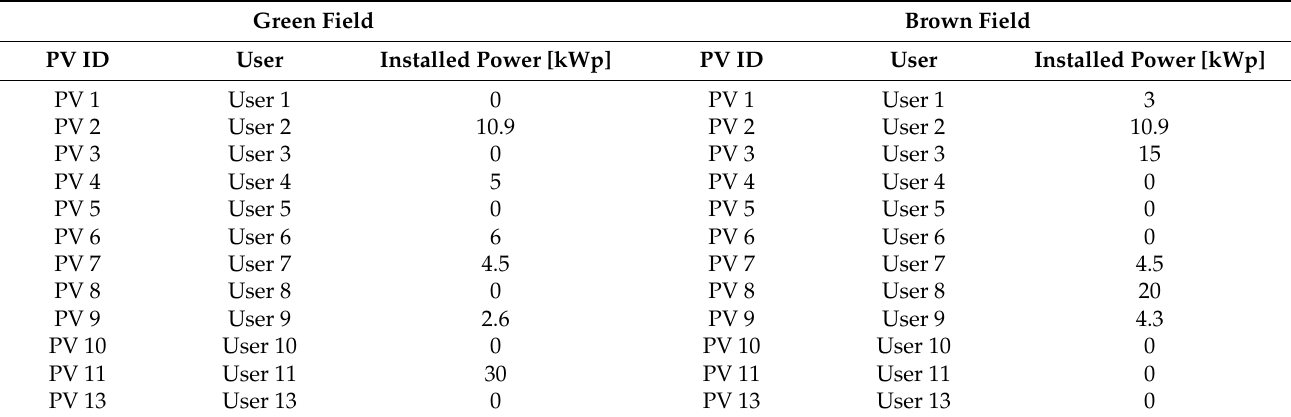
Table 6. Optimal power installed for each member for Case 1 (left side) and Case 2 (right side). Green Field Brown